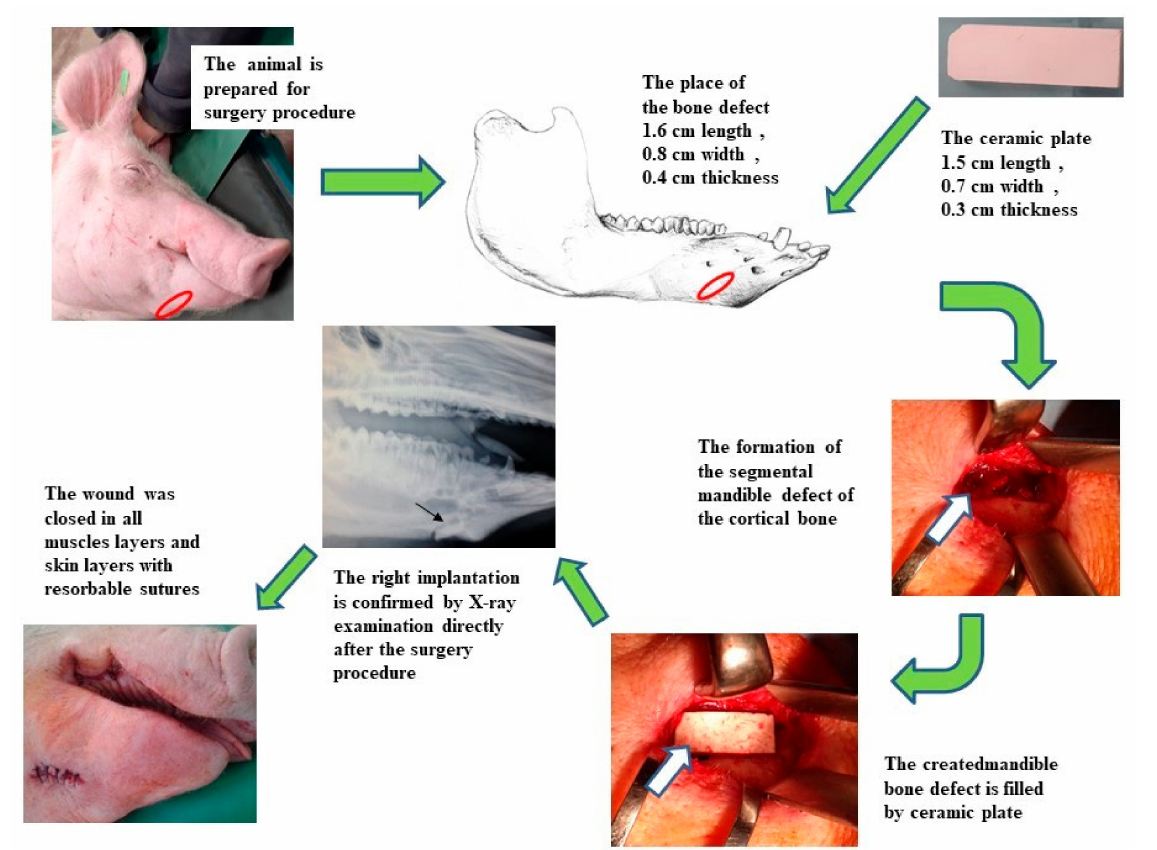
Figure 1. The scheme of the surgical procedure and postoperative evaluation of the HAP ceramic plate